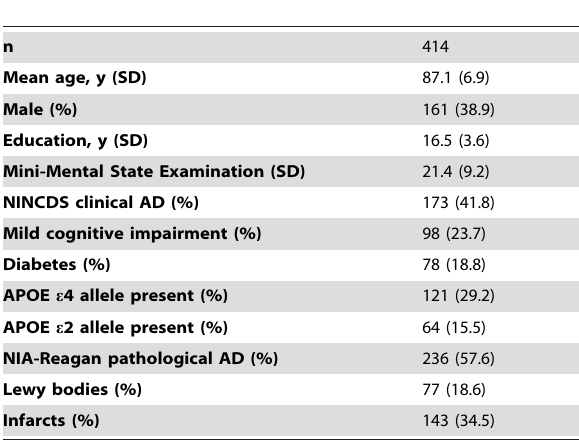
Table 1. Demographic, clinical and